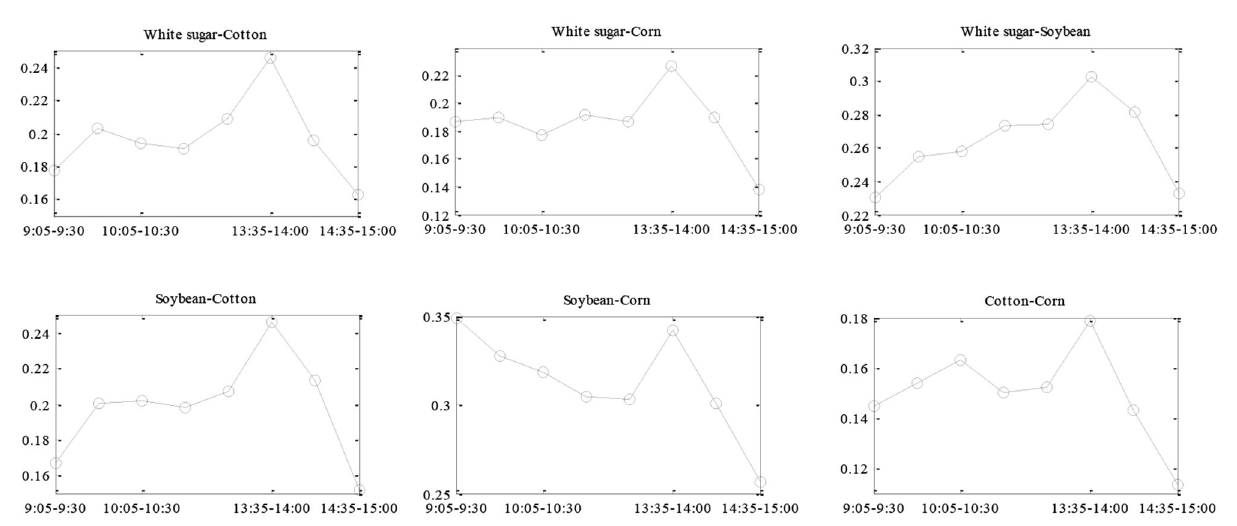
FIGURE6 The evolution of average intraday realized correlation. The intraday realized correlation is computed over 30-min intraday intervals and then averaged across each interval over the whole sample.